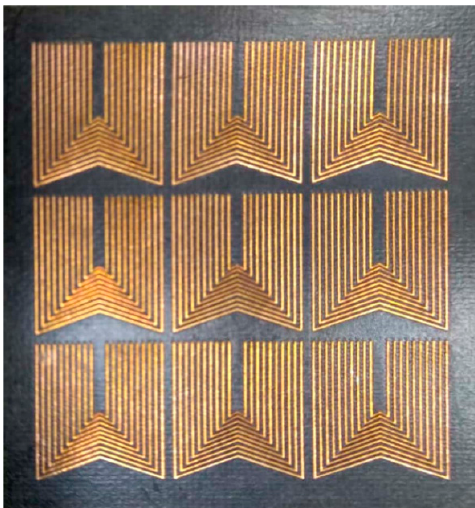
Figure 13. The fabricated code (ID: 1111111111).